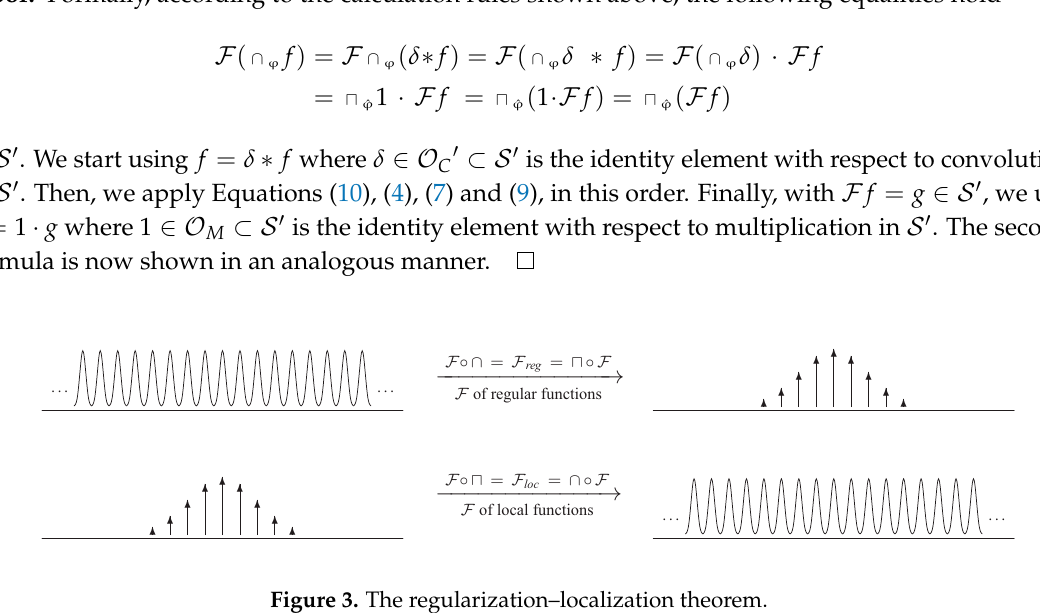
, linked via operations S (cid:48)